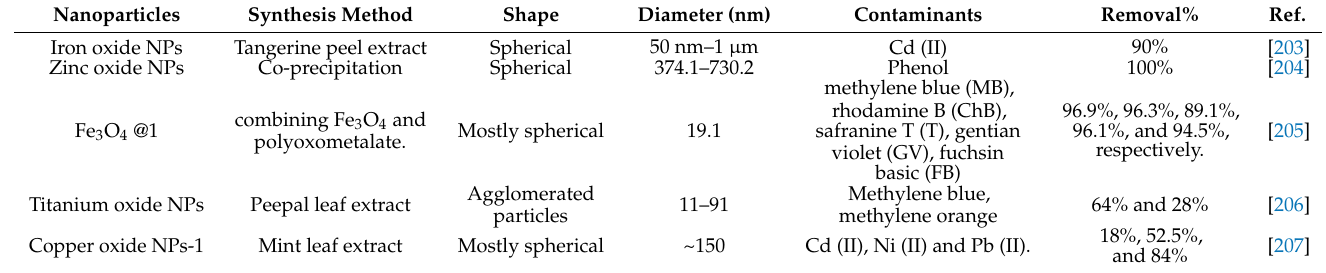
Table 4. Various nanoparticles are utilized for the removal of different contaminants from